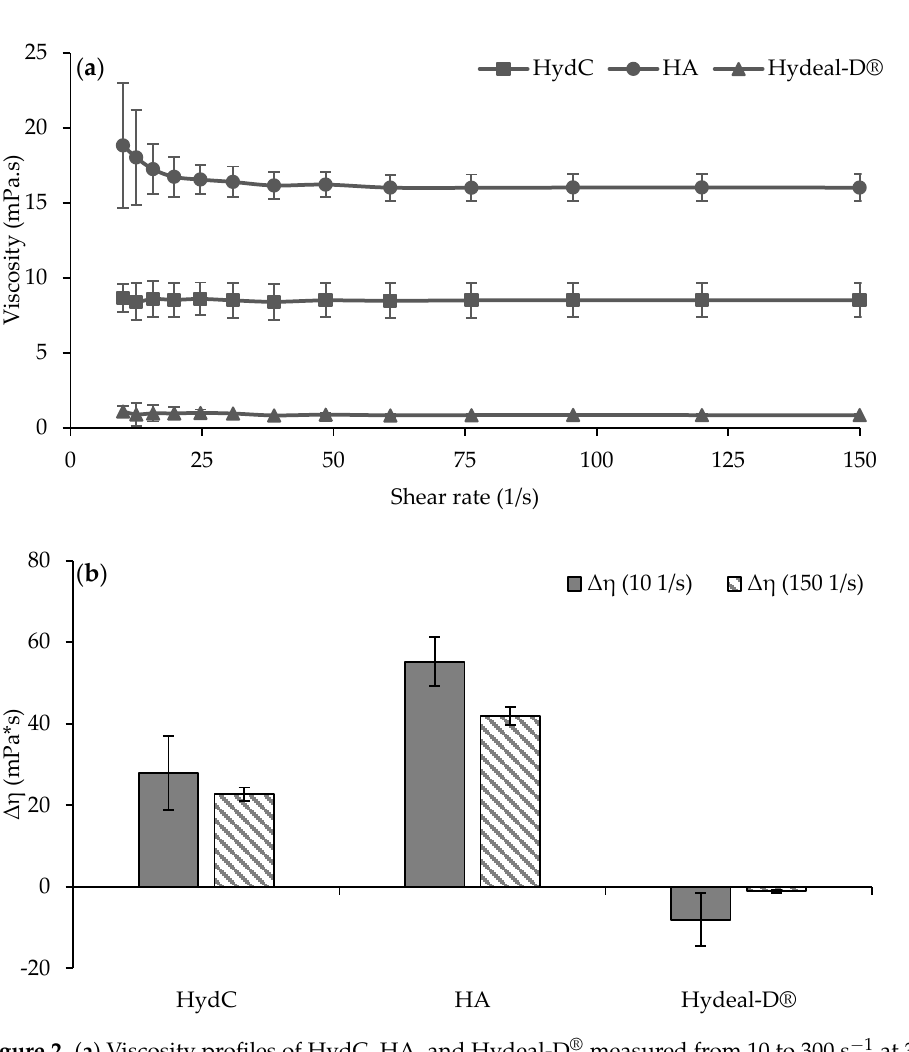
Figure 2. ( a ) Viscosity profiles of HydC, HA, and Hydeal-D ® measured from 10 to 300 s −1 at 37 °C (mean values ± s.d.; n = 3). ( b ) Values of the rheological synergism (Δη) at 10 to 300 s −1 obtained for all the samples after incubation with mucin dispersion (mean values ± s.d.; n = 3).